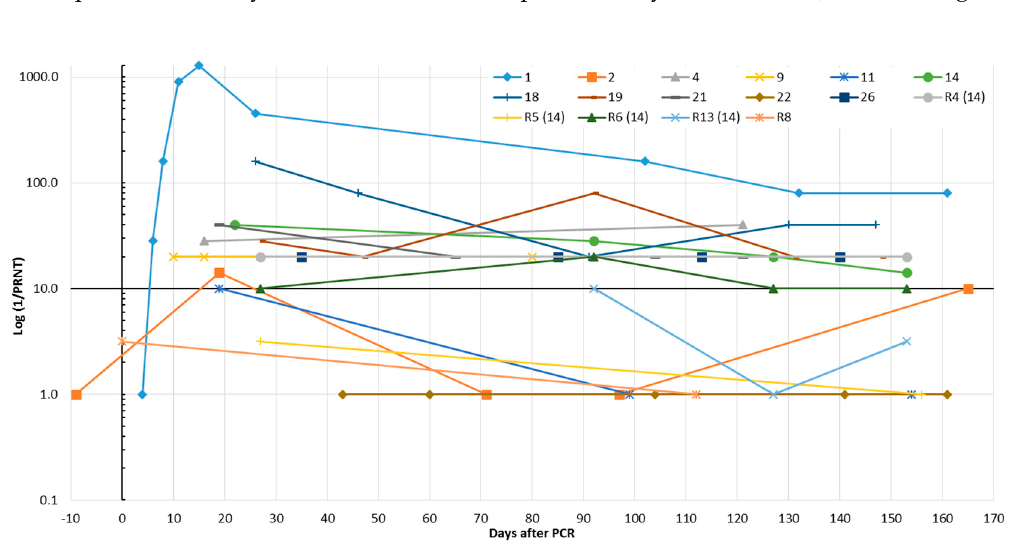
Figure 5. Time course of SARS-CoV-2-neutralizing antibodies in eleven SARS-CoV-2-infected patients and five routine (R) patients (including four family members of SARS-CoV-2 patient no. 14) who were interested in their SARS-CoV-2 antibody status. Results were obtained by the plaque reduction neutralization assay (PRNT, Figure S2). The reciprocal titer was calculated. If a clear titer could not be read, the geometric mean was given from the reciprocal values of the two neighboring titers.